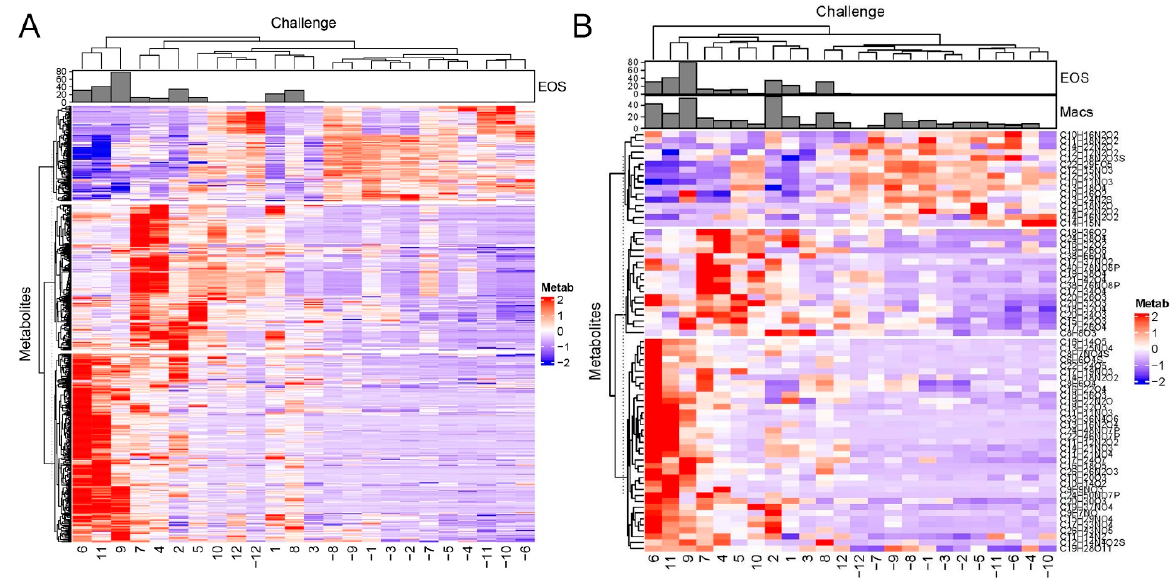
Figure 3. Hierarchical clustering. ( A ) Hierarchical cluster for 549 significant metabolites. Metabolite abundance was expressed by feature intensity and normalized by the z-score. Metabolites are rows, patients are columns. Patient IDs indicated by “-” are baseline (pre) challenge. Each patient is annotated by the number of eosinophils in the BALF sample (number × 10 4 )/mL shown in the bar graph at top. Note that three major clusters of patients (columns) were separated by pre- vs. post-treatment. ( B ) Hierarchical cluster with 72 identified metabolites. At the top is the annotation of eosinophil numbers (EOS) and macrophage numbers (Macs) in each sample. Note that, (1) the dendrograms are very similar; (2) volunteers subjected to SBP-Ag are clearly separated from the pre-challenge (columns); and (3) two distinct groupings of post-SBP-Ag are produced. Chemical formulas are shown on the right.